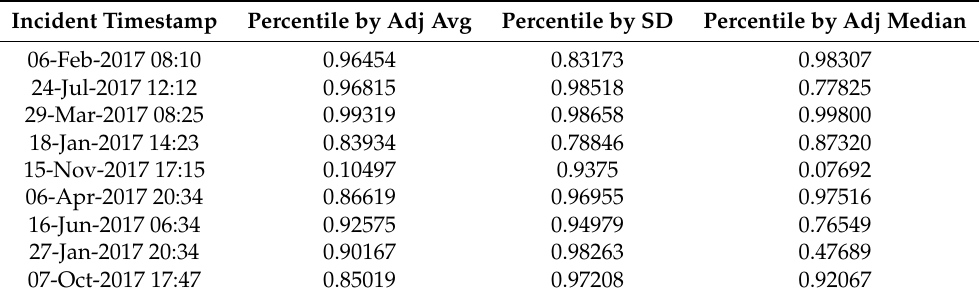
Table 12. Percentiles of Phase 2-Train incidents when sorted by sensor, day of week, and time of day based on their adjacency